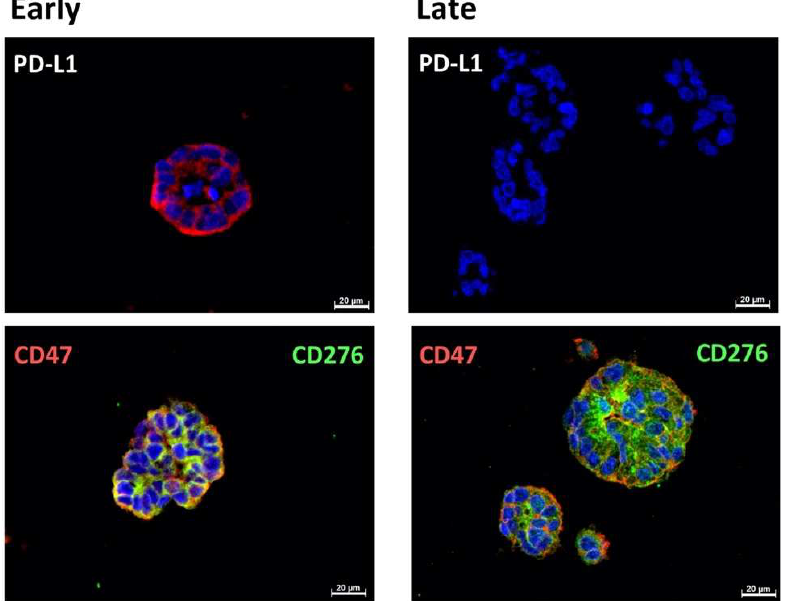
Figure 5. Expression of immune checkpoint antigens on BCO#154. Paraffin sections of organoids of BCO#154, a population with moderate in vitro growth capacity, were generated and stained in early passage ( left panel ) or in later passage ( right panel ) with antibodies reactive with PD-L1, CD276, and CD47 as indicated. In the bottom panel, CD47 is visualized by red fluorescence, CD276 by green fluorescence. Size bars indicate 20 μm, respectively.